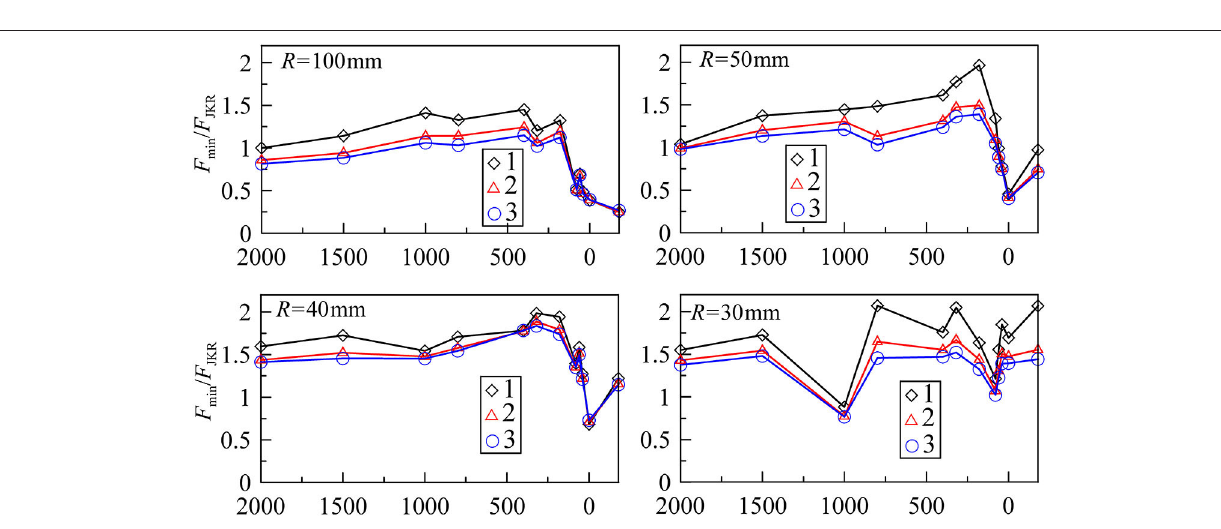
Frontiers in Mechanical Engineering |